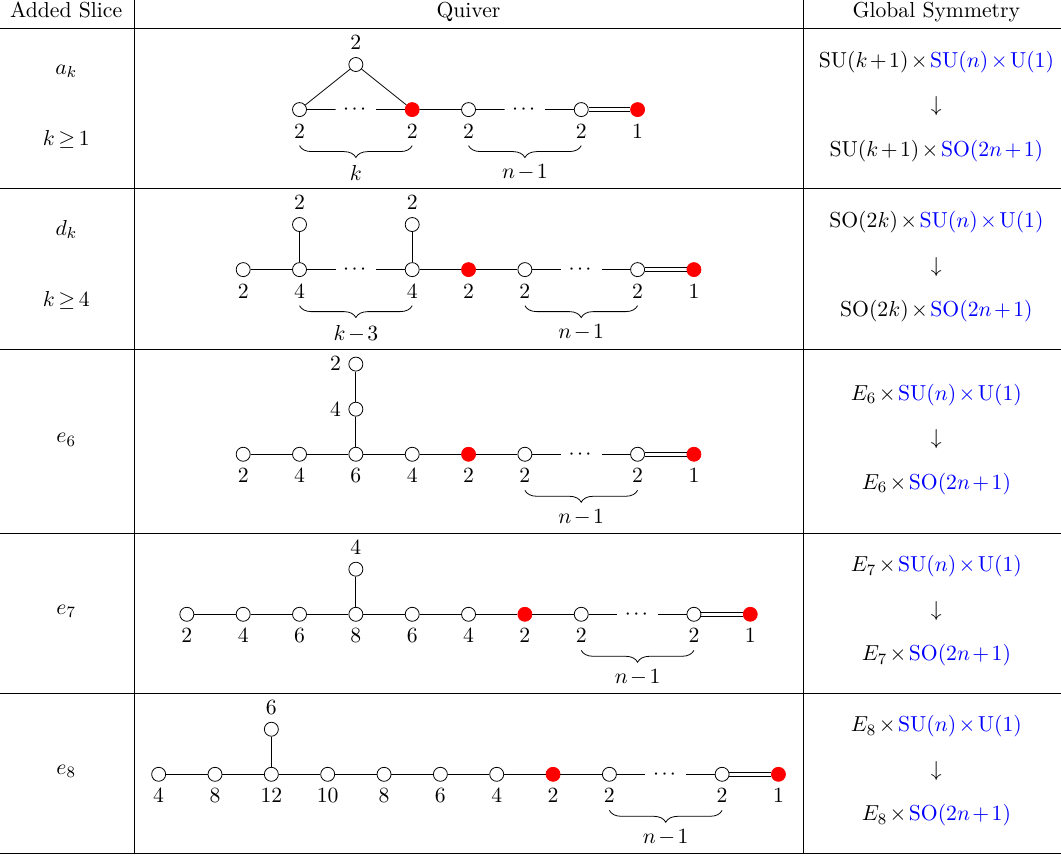
Table 10 . Quivers resulting from adding all possible simply laced elementary slices to the empty nodes of (4.9) to absorb a